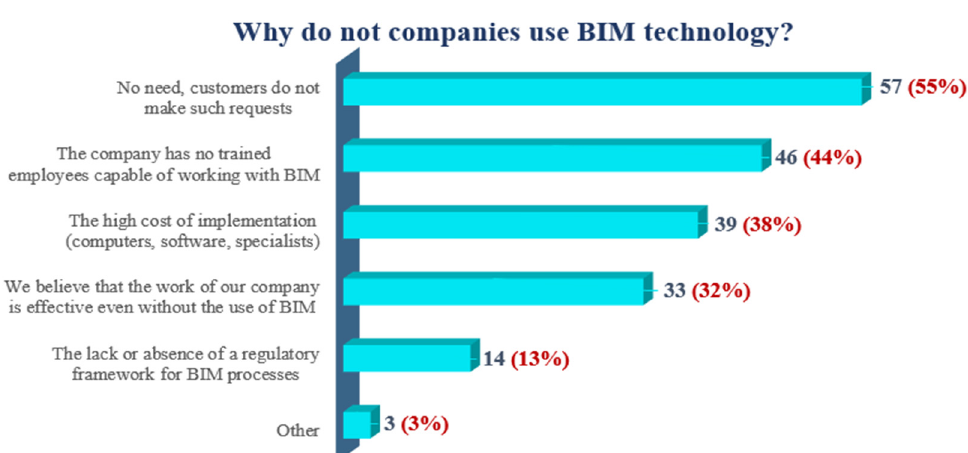
Figure 9. Clash detection and resolution process.